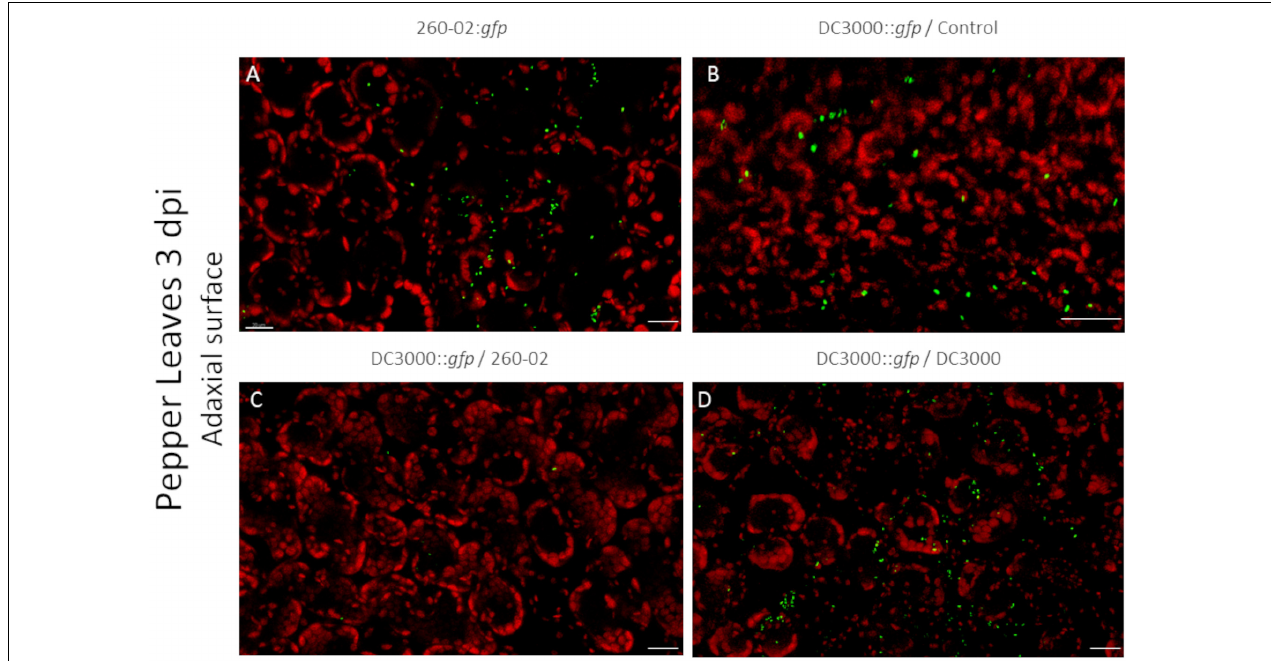
FIGURE 8 | Confocal microscopy on the adaxial surface of pepper leaves at 3 dpi. The panel shows representative pictures from the microscopy observations. In green is the fluorescence obtained by exciting with a wavelength of 488 nm, which produces fluorescence from the GFP used to tag the bacterial strains, in red that obtained by exciting with a wavelength of 594 nm, which produces autofluorescence from chlorophyll and visualizes the position of chloroplasts. Yellow color is given by overlap of red and green fluorescence. Panel (A) is from leaves experimentally inoculated with a suspension of strain 260-02: gfp cells; panel (B) is from leaves experimentally inoculated with a suspension of strain DC3000:: gfp cells taken from plants without any root treatment; panel (C) is from leaves experimentally inoculated with a suspension of strain DC3000:: gfp cells taken from plants treated at the root with strain 260-02; panel (D) is from leaves experimentally inoculated with a suspension of strain DC3000:: gfp cells taken from plants treated at the root with strain DC3000. In each picture, the scale bar reported in the lower right corner represents 20 µ